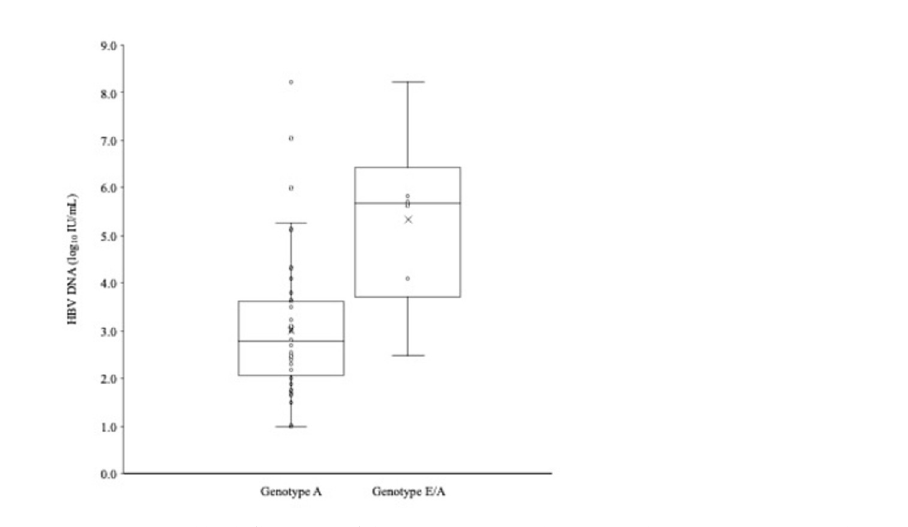
Fig 3. HBV viral loads (log 10 IU/mL) for genotype A samples compared to genotype E/A recombinant